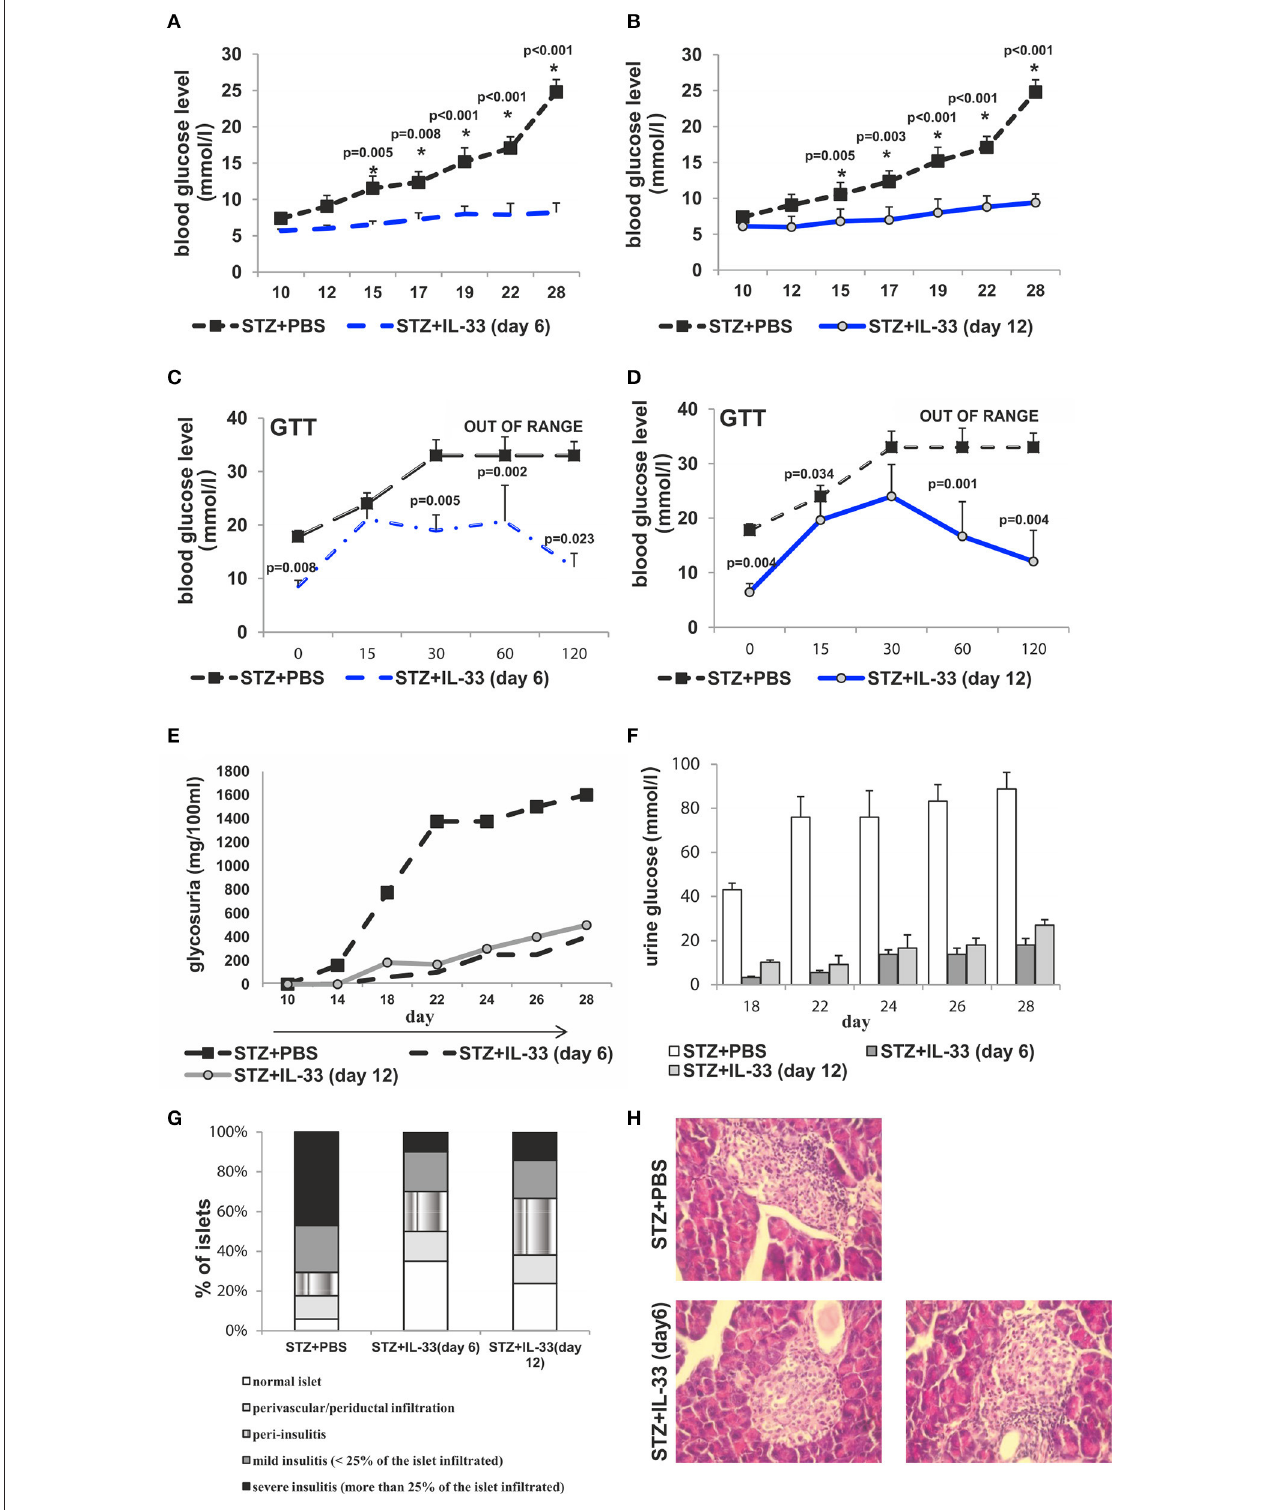
FIGURE 6 | IL-33 given 6 and 12 days after diabetes induction partially attenuates clinical signs and influx of inflammatory cells in the islets. Effect of four injections of 0.4 µ g/mouse IL-33 on glycemia (A,B) , GTT test (C,D) and glycosuria (E,F) Histology of the islet showed significantly ( p < 0.001) decreased influx of mononuclear cells in IL-33 treated group in comparison with control group (G,H) . An analysis of lymphocytic infiltrates in Langerhans’s pancreatic islands was performed by light microscope using a magnifying lens of 40 X.